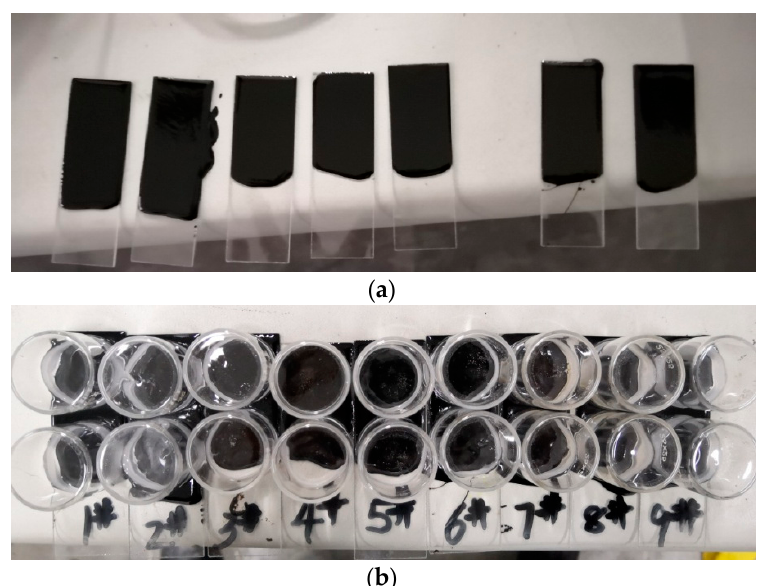
Figure 2. Photographs of AFM sample preparation (( a ) keep the sample in a horizontal state; ( b ) dust ‐ proof).